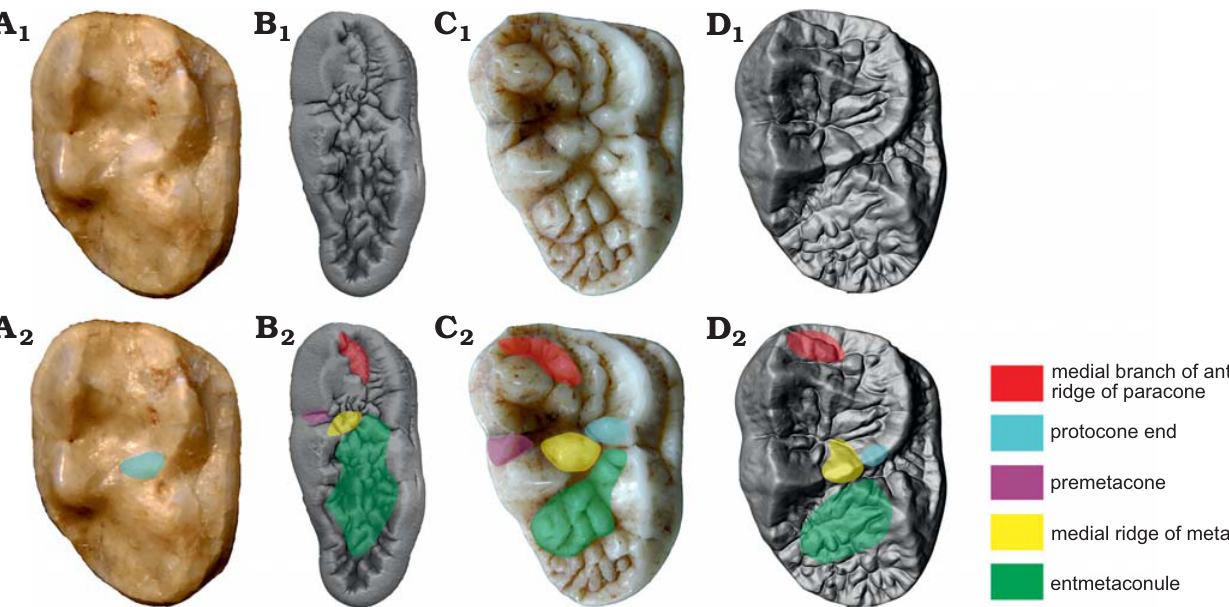
Fig. 6. Occlusal views of M2 homologous structures in cave bear (A, B) and giant panda (C, D) lineages. A . Ursavus tedfordi Qiu, Deng, and Wang, 2014 (HMV1453) from Huaigou, Gansu Province, Late Miocene. B . Ursus deningeri Von Reichenau, 1904 (NMM1953/119, photo Jan Wagner) from Mosbach 2, Germany, early Middle Pleistocene. C . Ailuropoda melanoleuca (David, 1869) (IVPP V87025.153) from cave deposit of Guangxi Province, Late Pleistocene. D . Ailurarctos lufengensis Qiu and Qi, 1989 (IVPP V6892) from Lufeng, Yunnan Province, Latest Miocene. A 1 –D 1 , photographs; A 2 –D 2 , photographs with homologous structures indicated. Not to scale.